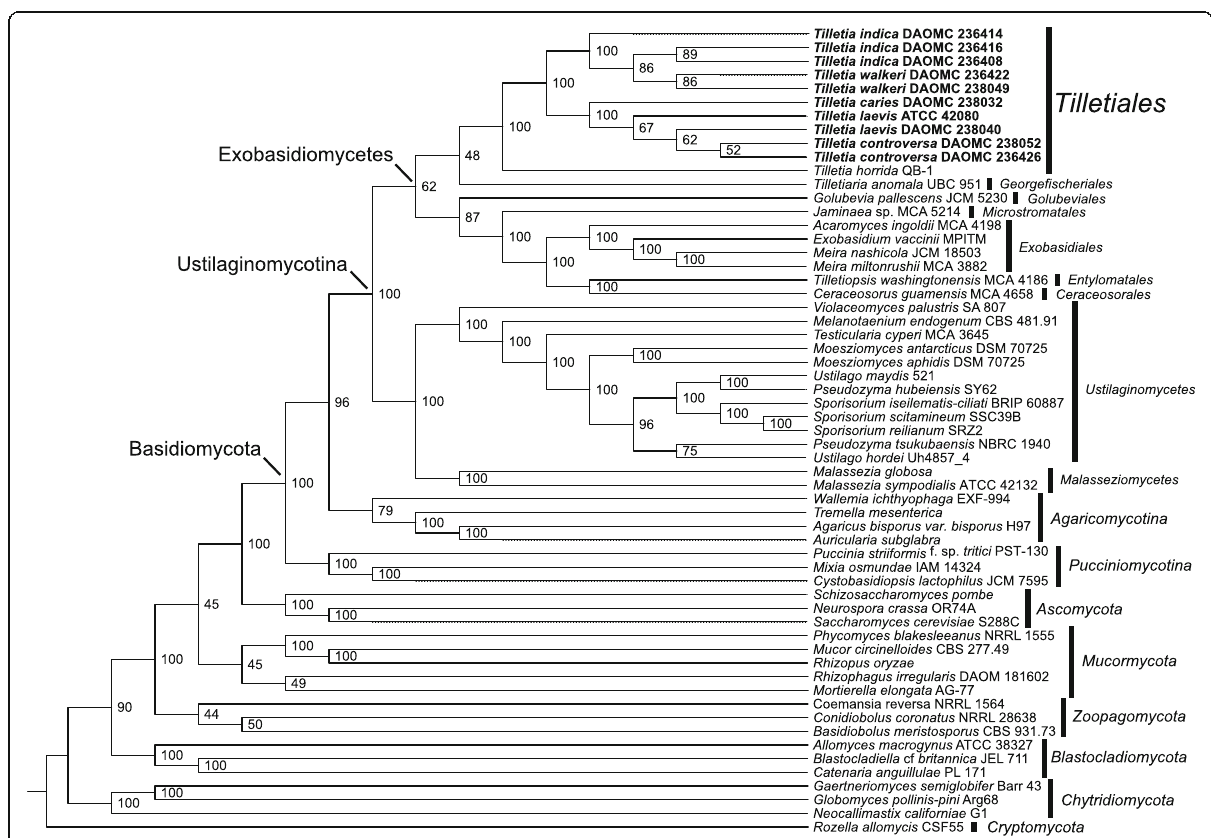
Fig. 4 ASTRAL greedy consensus cladogram based on analyses of individual bootstrap trees for each of 192 conserved orthologous proteins placing Tilletia in Kingdom Fungi. Support values show the percentage of bootstrap replicates that contain that